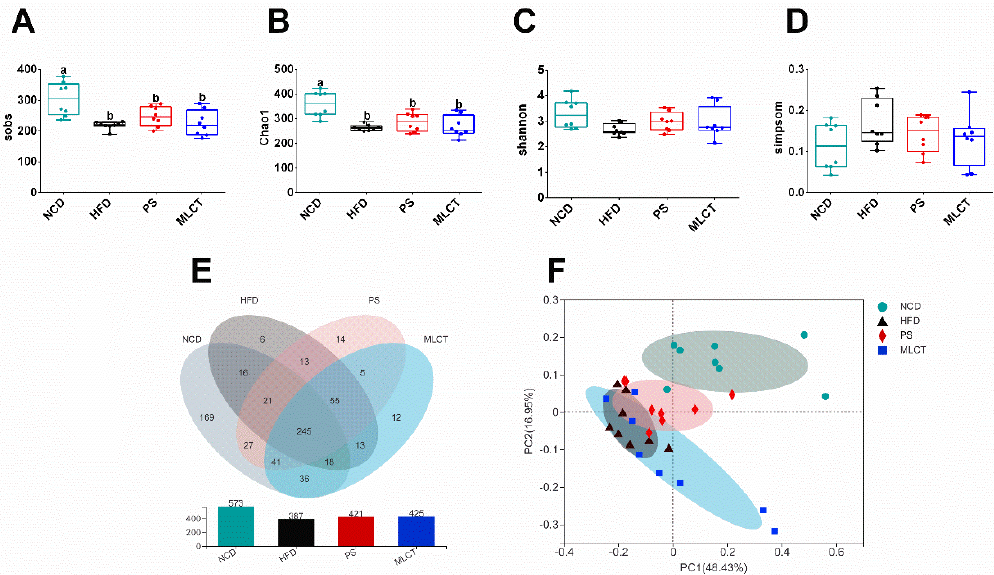
Figure 6. Effects of MLCT on diversity of the gut microbiota. ( A ) Sobs. ( B ) Chao1. ( C ) Shannon. ( D ) Simpson. ( E ) OTUs Venn Diagram. ( F ) PCoA plot (weighted UniFrac distances). Data were shown as mean ± SE ( n = 8). In ( A – D ), means with the different lowercased letters differ significantly ( p < 0.05) according to one-way ANOVA analysis followed by Tukey’s tests.